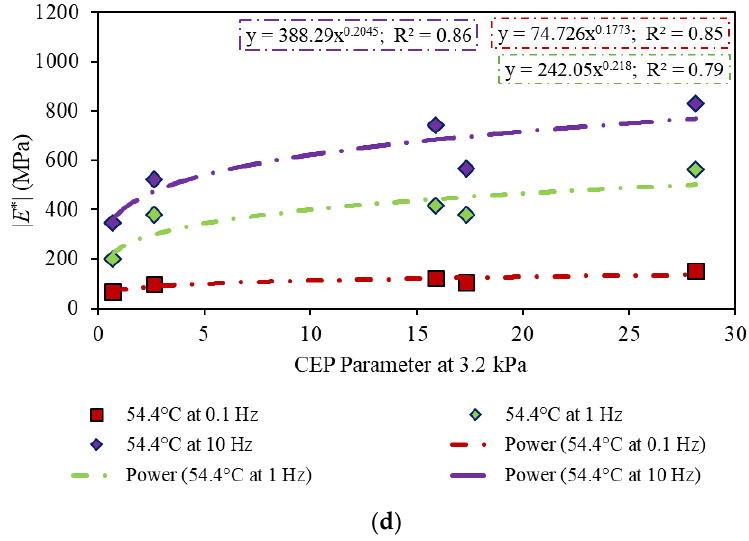
Figure 8. Correlations of asphalt mix rutting parameters from the Dynamic Modulus test with ( a ) J nr at 0.1 kPa, ( b ) J nr at 3.2 kPa, ( c ) CEP parameter at 0.1 kPa, and ( d ) CEP parameter at 3.2 kPa.